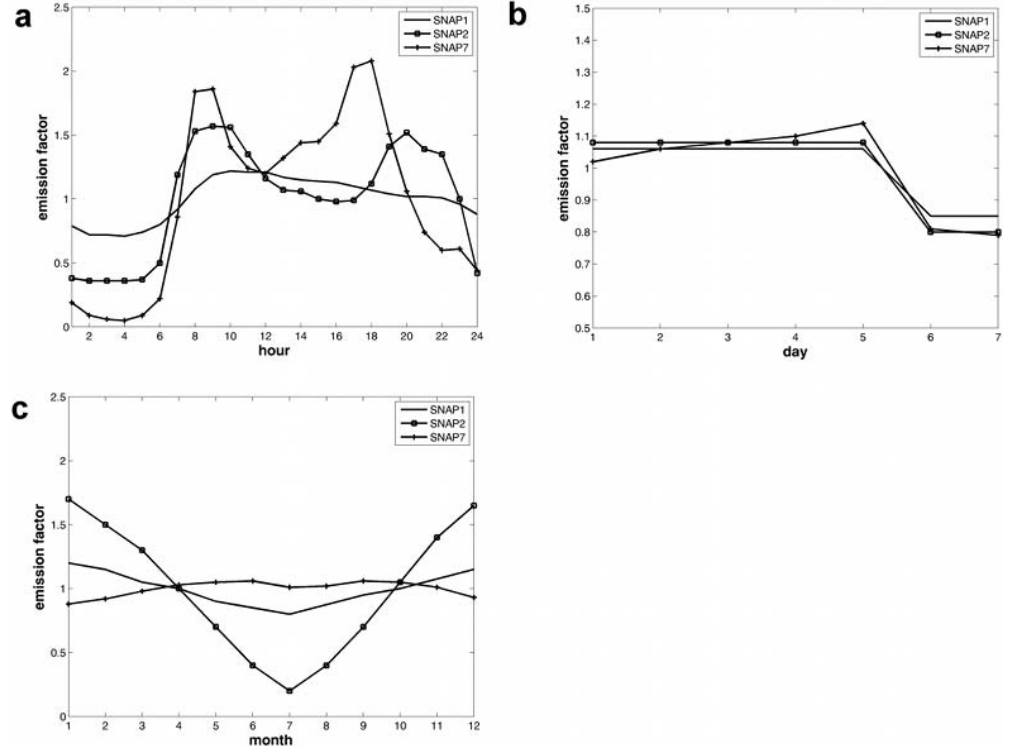
Fig. 1. Overview of the LOTOS-EUROS default diurnal cycle (a) , weekly cycle (b) and seasonal cycle (c) of emission factors for the SNAP1, SNAP2 and SNAP7